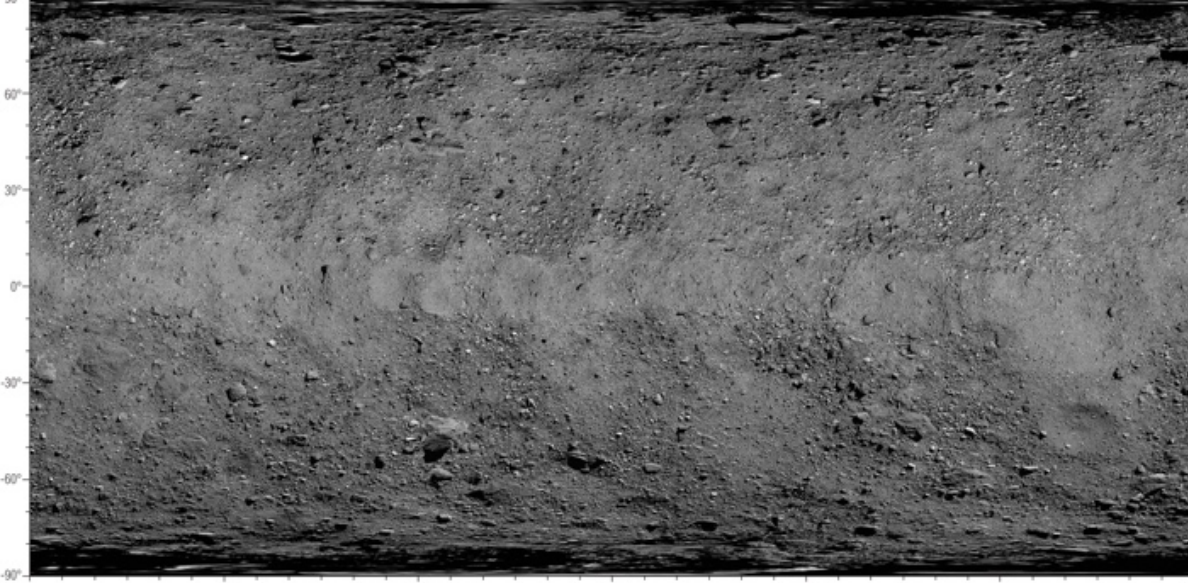
Figure 5. Global panchromatic basemap of Bennu created from 2155 OCAMS PolyCam images acquired at a pixel scale of ~5 cm (Bennett et al., 2020). Projection is